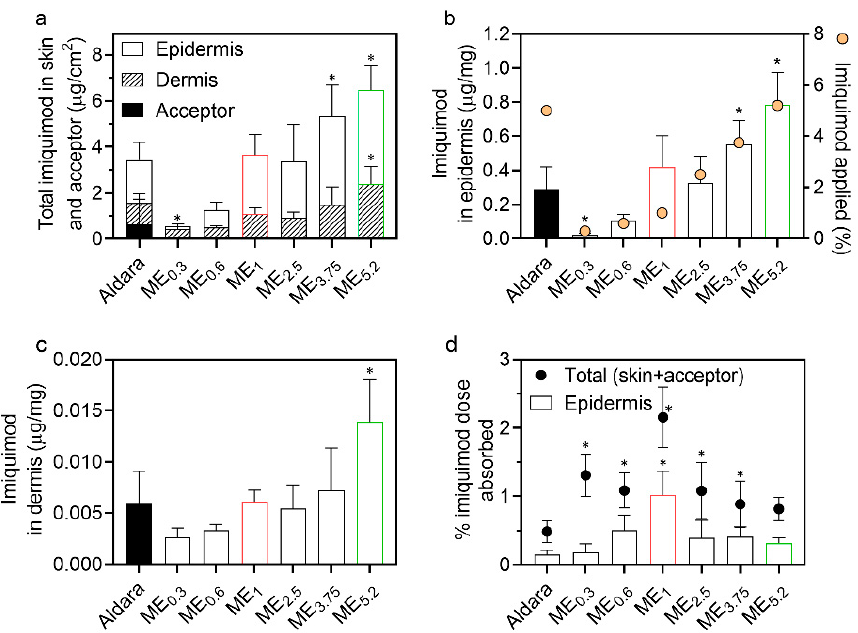
Figure 4. Effect of MEs on IMQ permeation and deposition in human skin in vitro. ( a ) IMQ amounts found in the epidermis, dermis, and acceptor, ( b ) IMQ concentrations in the epidermis (bars) and IMQ concentration in the formulation (circles), ( c ) IMQ concentrations in the dermis, and ( d ) proportion of the applied IMQ dose that reached the epidermis (bars) and total IMQ absorbed (circles). Data are presented as the means ± SD, n ≥ 4. * Statistically significant difference compared to Aldara at p < 0.05. Formulations selected for further experiments, ME 1 and ME 5.2 , are highlighted in red and green, respectively.